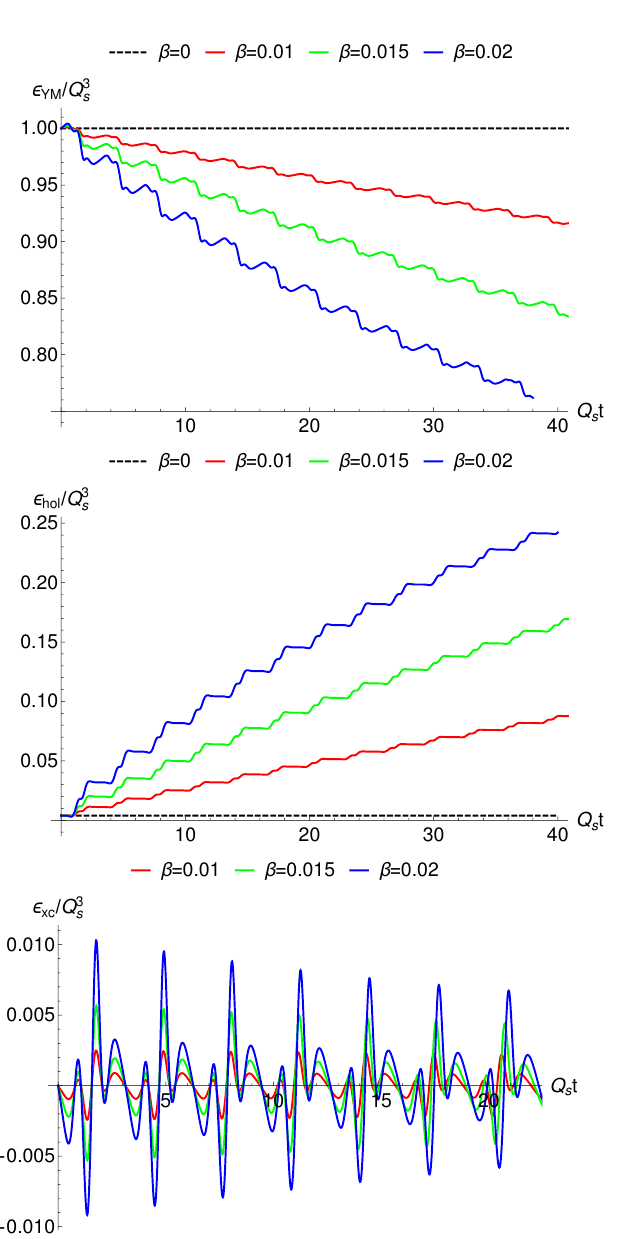
Figure 3 . Upper: the energy density of the YM sector against time. Middle: the energy density of the holographic sector. Lower: the exchange energy as a function of